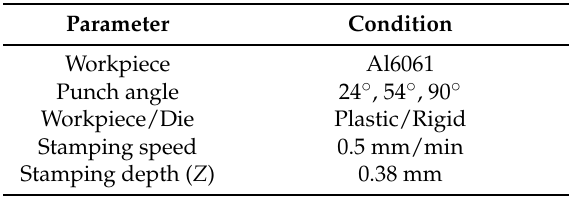
Table 1. Simulation parameters of DEFORM ‐ 3D.